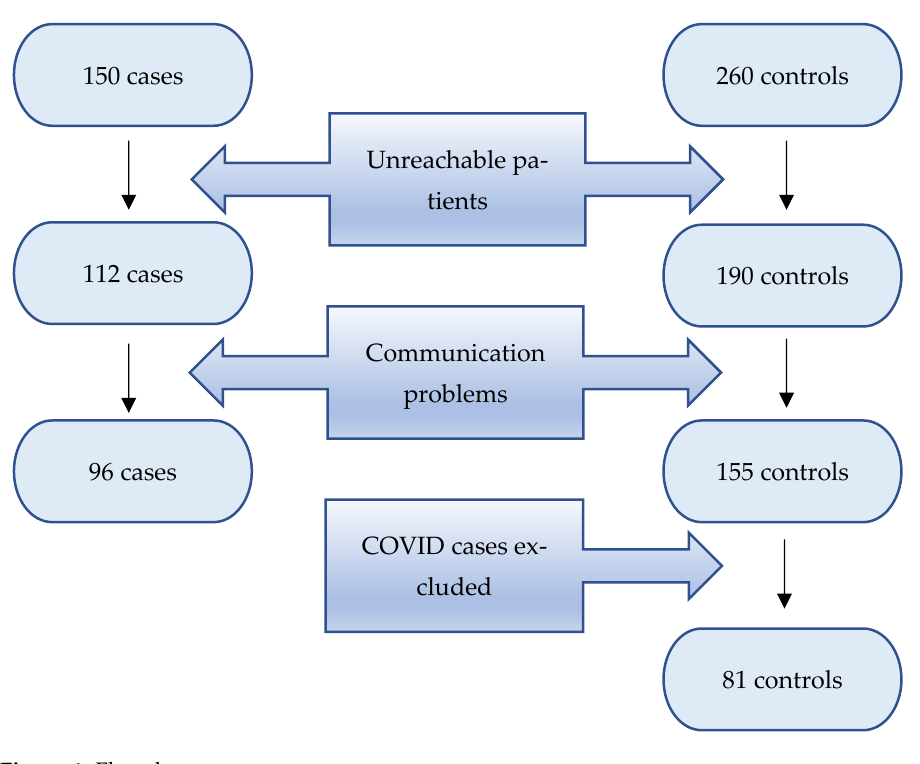
Figure 1. Flowchart. Table 1. Symptoms and quality of life of 177 patients at 1 year after their visit in a COVID ambula- tory